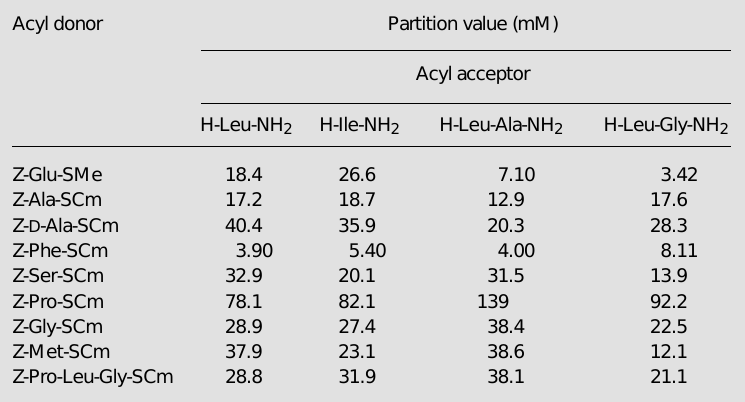
Table 4 - Partition values of V8 protease-catalyzed acyl transfer reactions of carboxy- methyl thioester substrate mimetics with amino acid and dipeptide amides compared to Z-Glu-SMe